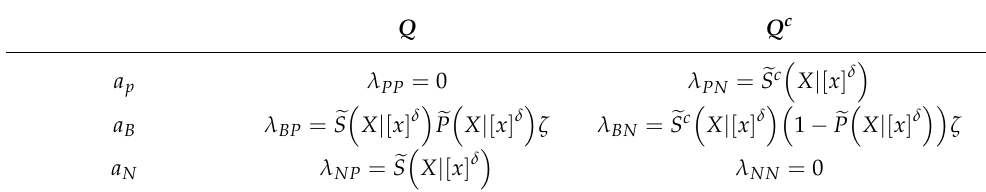
Table 2. The fuzzy neighborhood data-driven loss function